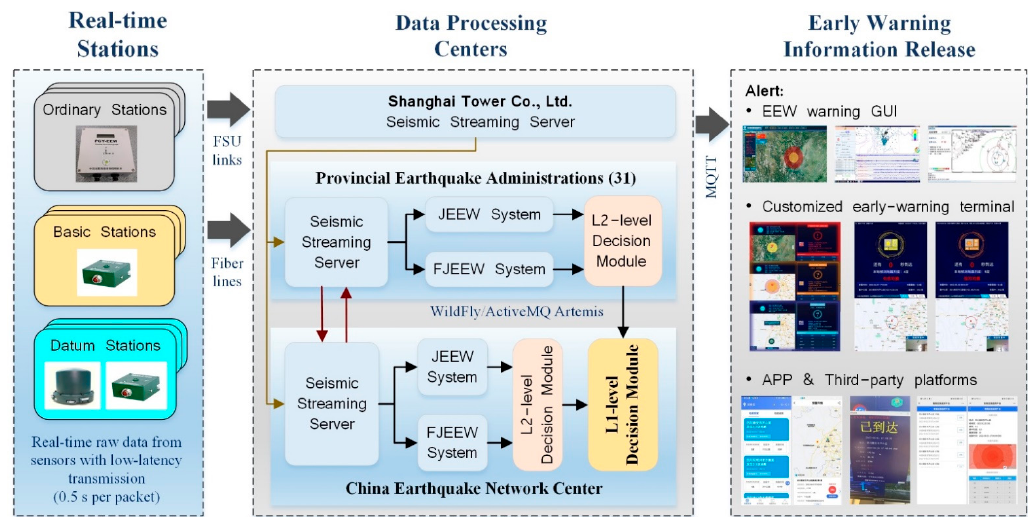
Figure 2. Processing flowchart presenting the software system architecture of the Chinese national EEWS. Data processing flows from the real-time stations, through the data processing centers to the early warning information release terminals, which publishes alerts for subscribers through the Message Queuing Telemetry Transport (MQTT) protocol. Redundant data processing centers in the China Earthquake Network Center and provincial earthquake administrations protect the system against power losses, hardware failures, and loss of connectivity due to earthquakes or other causes. At each center, the uninterruptible power supply (UPS) is used to ensure that the local system is still functioning properly when the center power fails. Multiple data processing centers can back up each other to ensure that when one processing center fails, for example for a possible collapse of the hosting building, the entire EEWS can still work normally. ActiveMQ Artemis in WildFly is used for message communication between each sub-system and each data processing center. JEEW System, a Java-based EEWS developed by Shenzhen Academy of Disaster Prevention and Reduction; FJEEW System, an EEWS developed by Fujian Earthquake Administration; GUI, graphic user interface; APP, mobile application.